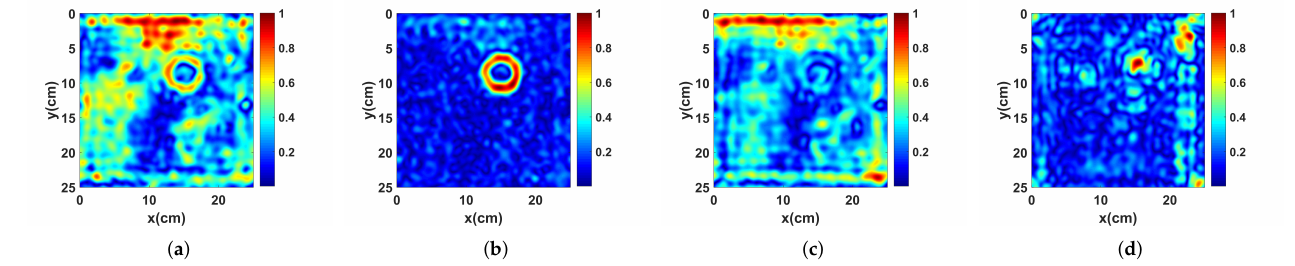
Figure 4. HSR images obtained from different clutter before and after using the standard autoen- coder. ( a ) Imaging result of Scene I. ( b ) Autoencoder result of Scene I. ( c ) Imaging result of Scene II. ( d ) Autoencoder result of Scene